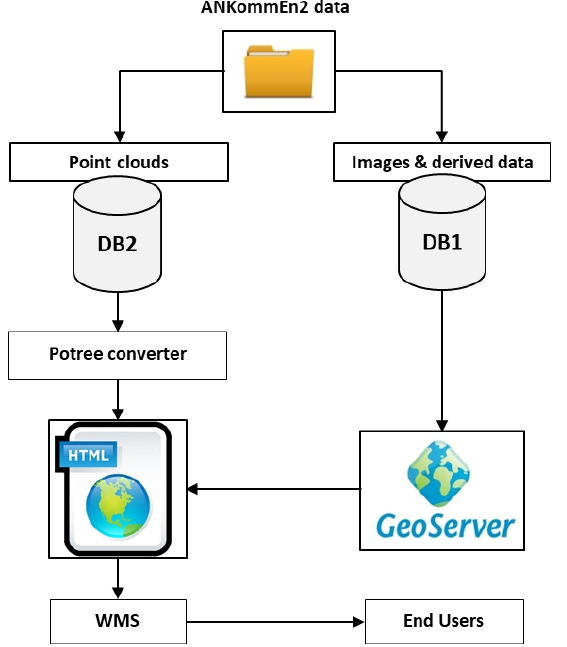
Figure 17: Principle of distributing geospatial information